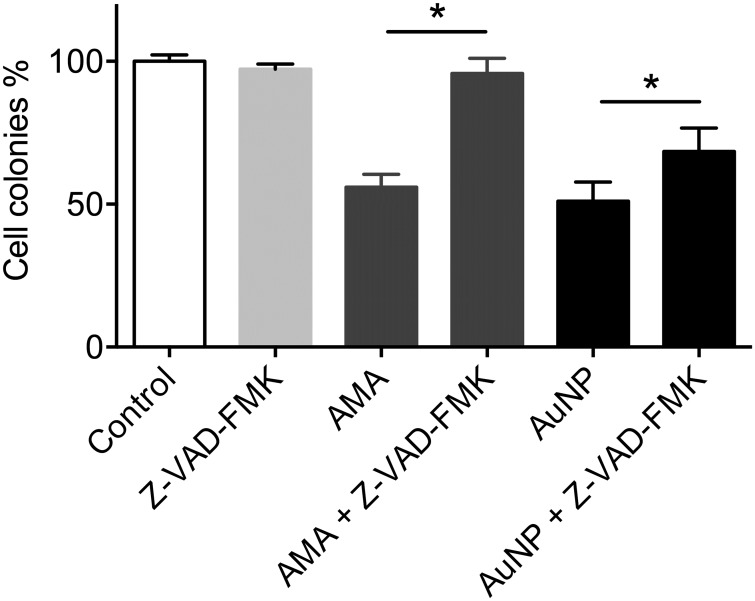
Clonogenic assay of HSC-3 cells, demonstrating a partial rescue of 50:50 αGal:PEG-amine AuNP-induced cell death by 50 μM Z-VAD-FMK caspase inhibitor.10 μM Antimycin A was used as an apoptosis positive control. For each condition, n = 3 and data are presented ±SEM. * Denotes a significant difference (P<0.05 ANOVA, Tukey multiple comparisons post-test).